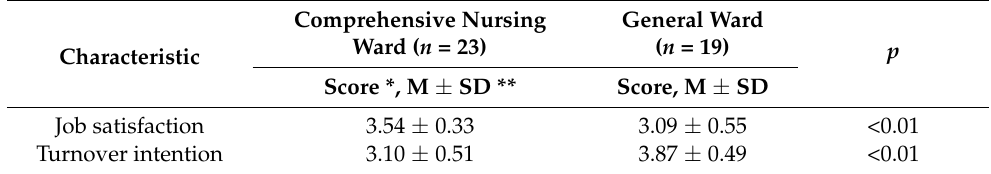
Table 4. Comparison of nurses’ job satisfaction and turnover intention ( n =